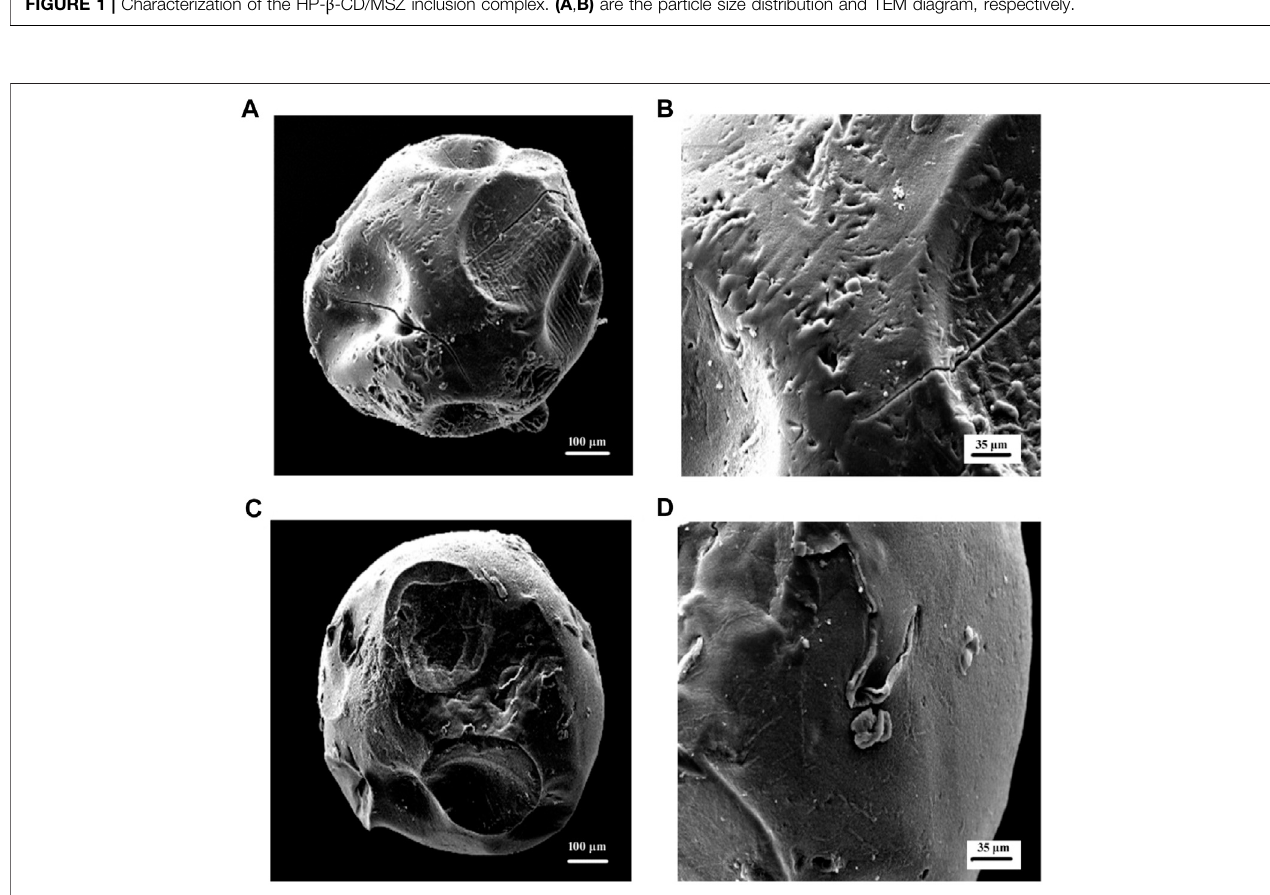
FIGURE2|(A , B) areSEMmicrographs(300x)(100kx)ofAlghydrogelbeadsindrycondition; (C , D) areSEMmicrographs(300x)(100kx)ofAlg/Cs/Carhydrogel beads in dry condition.